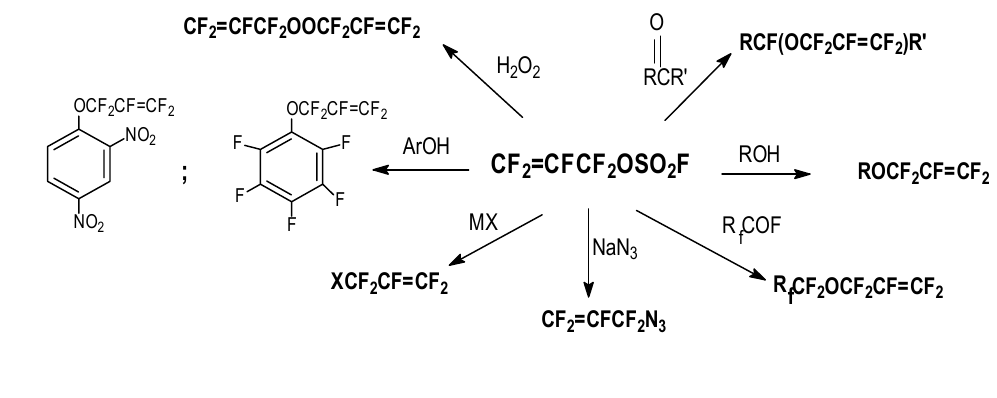
Scheme 6. Generalized product library possible with FAFS.